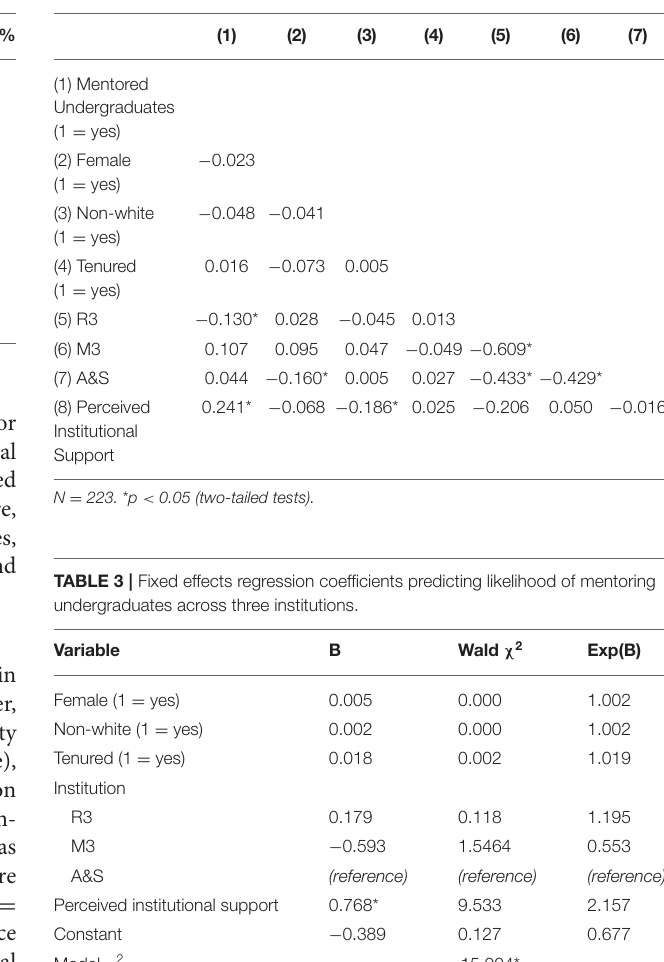
TABLE 2 | Zero-order correlations for analytic variables.